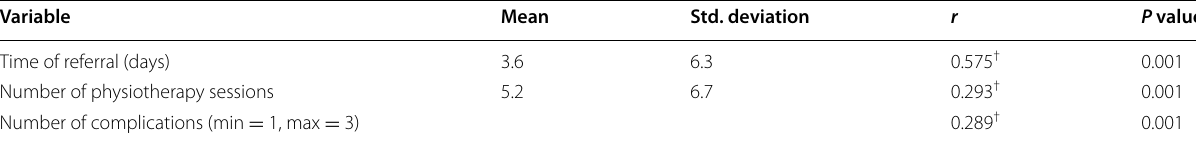
Key: † Pearson correlation is significant at p <